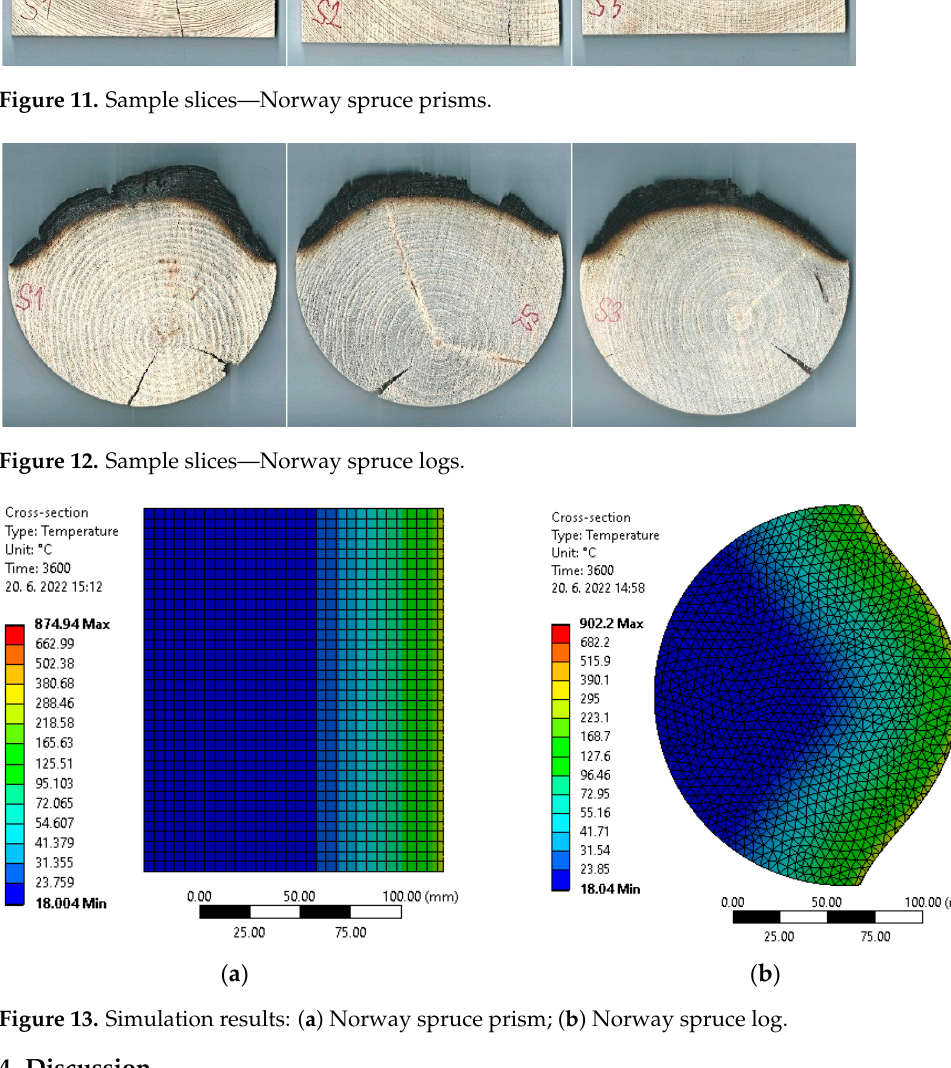
Figure 13. Simulation results: ( a ) Norway spruce prism; ( b ) Norway spruce log.